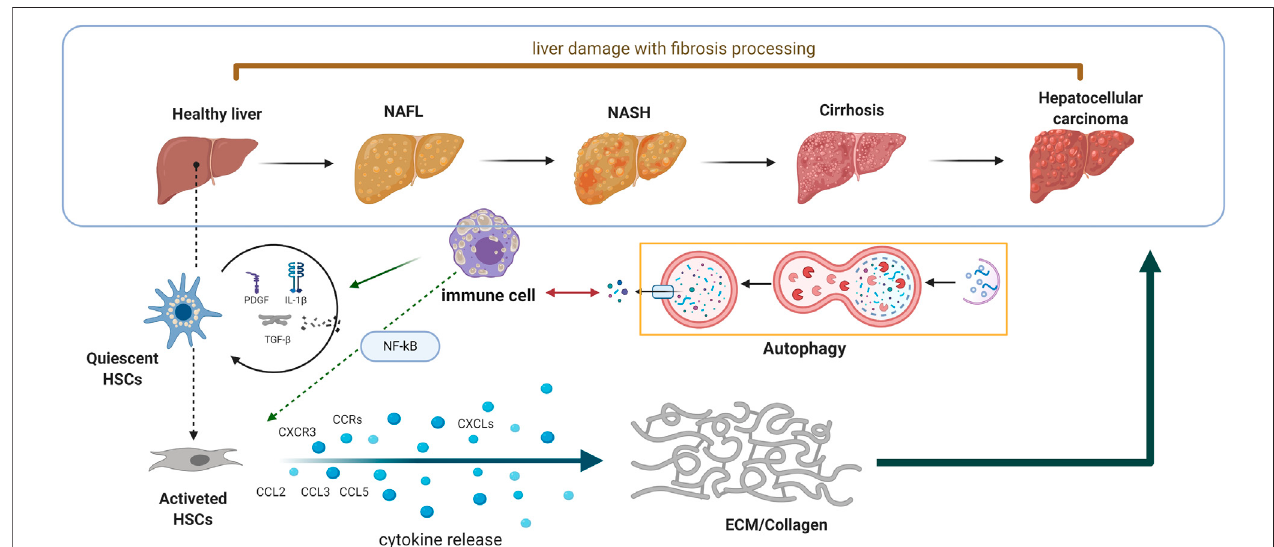
FIGURE 1 | Schematic diagram of the interaction between autophagy and innate immunity in the process of liver fi brosis. When the liver encounters sustained damage, the immune cells will generate huge amount of chemokines and cytokines to exert its defensive reaction. Meanwhile, the HSCs also express different kinds of chemokine receptors to further promote matrix